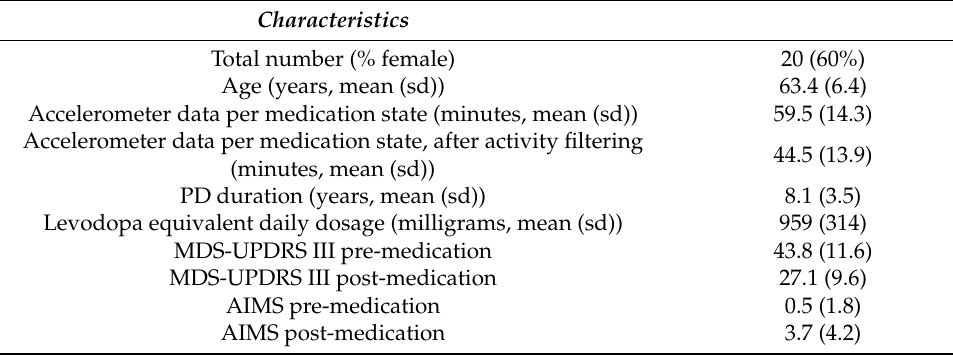
Table 1. Demographic and disease specific characteristics of patient population. AIMS: Abnormal Involuntary Movement Scale. MDS-UPDRS: Movement Disorders Society Unified Parkinson Disease Rating Scale. Sd: standard